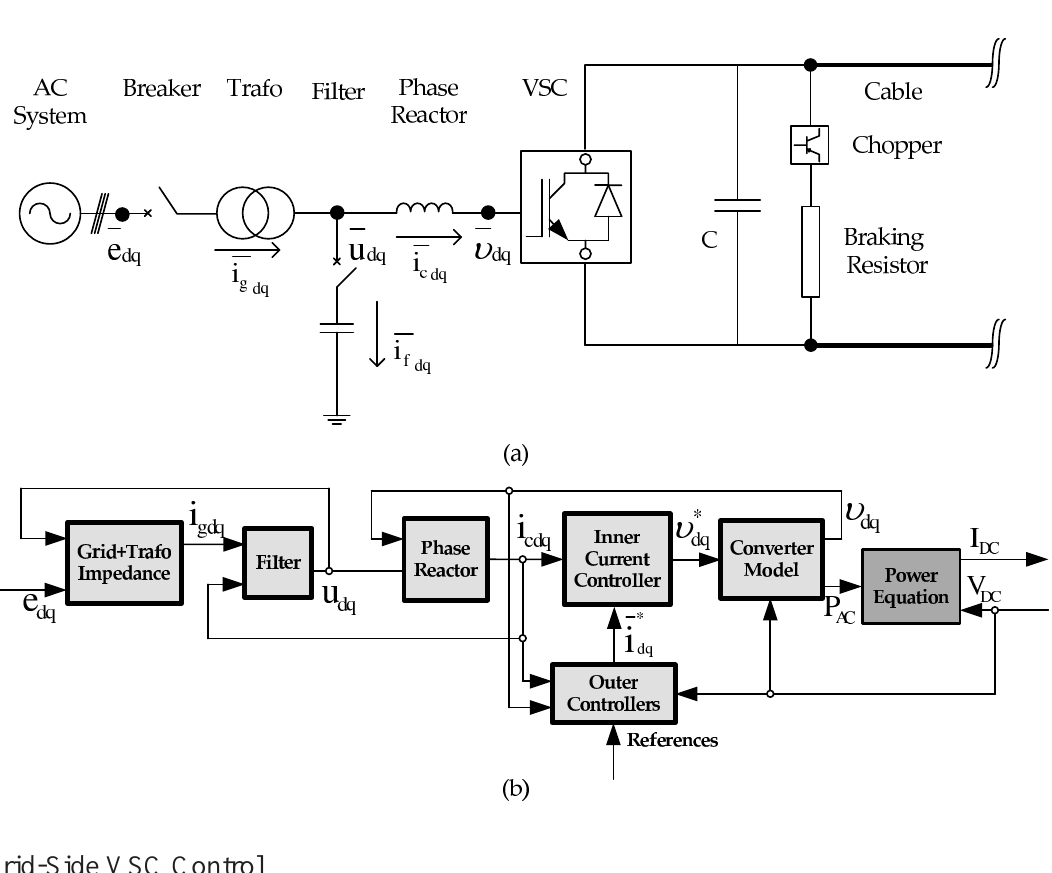
( a ) Single-line diagram of the VSC-HVDC model; ( b ) Signal flow inside the